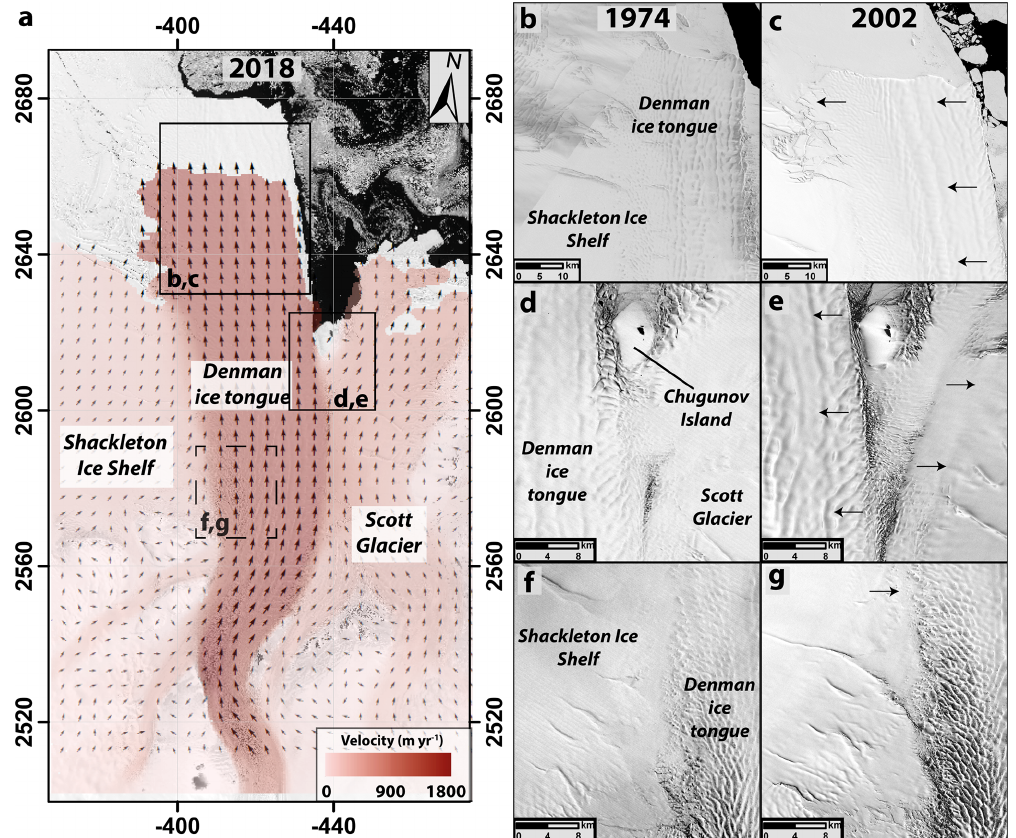
Figure 4. (a) Landsat-8 image overlain with MEaSUREs velocity vectors (Rignot et al., 2011b). (b, d, f) Close-up examples of ice tongue structure and position from a Landsat-1 image in 1974. (c, e, g) Close-up examples of ice tongue structure and position from a Landsat-7 image in 2002. In particular, note the reduction in contact between Denman Glacier and Chugunov Island between 1974 (d) and 2002 (e) . The arrows in panels (c) , (e) and (g) represent the direction of migration of the Denman ice tongue since 1974. All Landsat images in this figure have been made available courtesy of the U.S. Geological